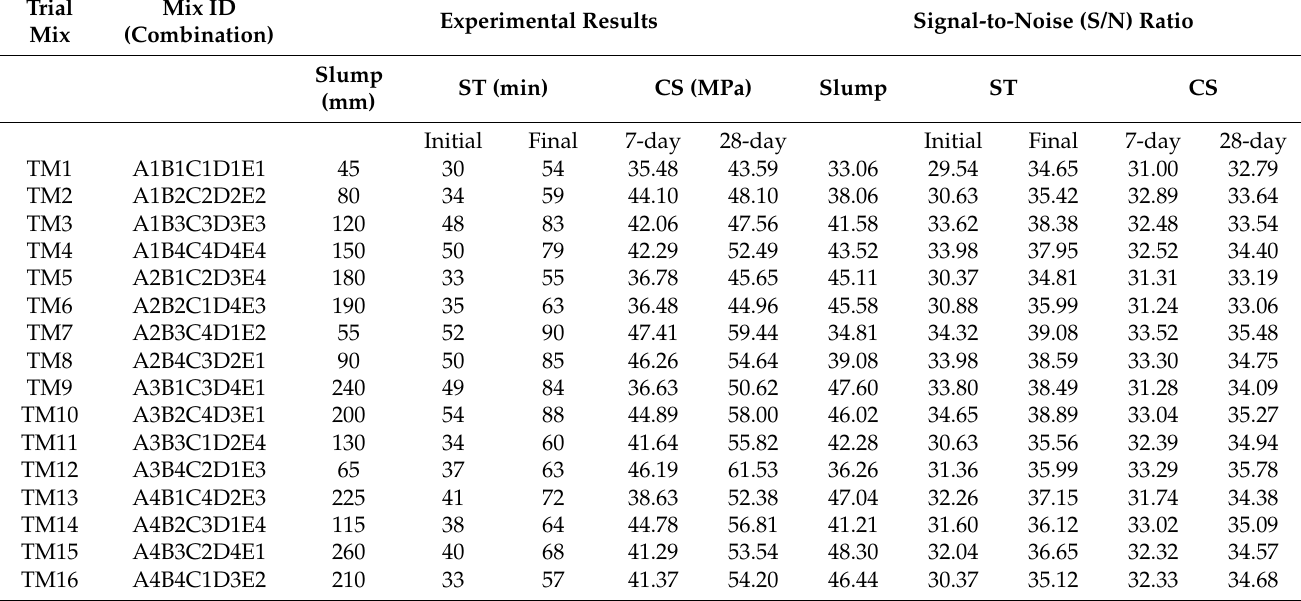
Table 4. Experimental results and signal-to-noise (S/N)